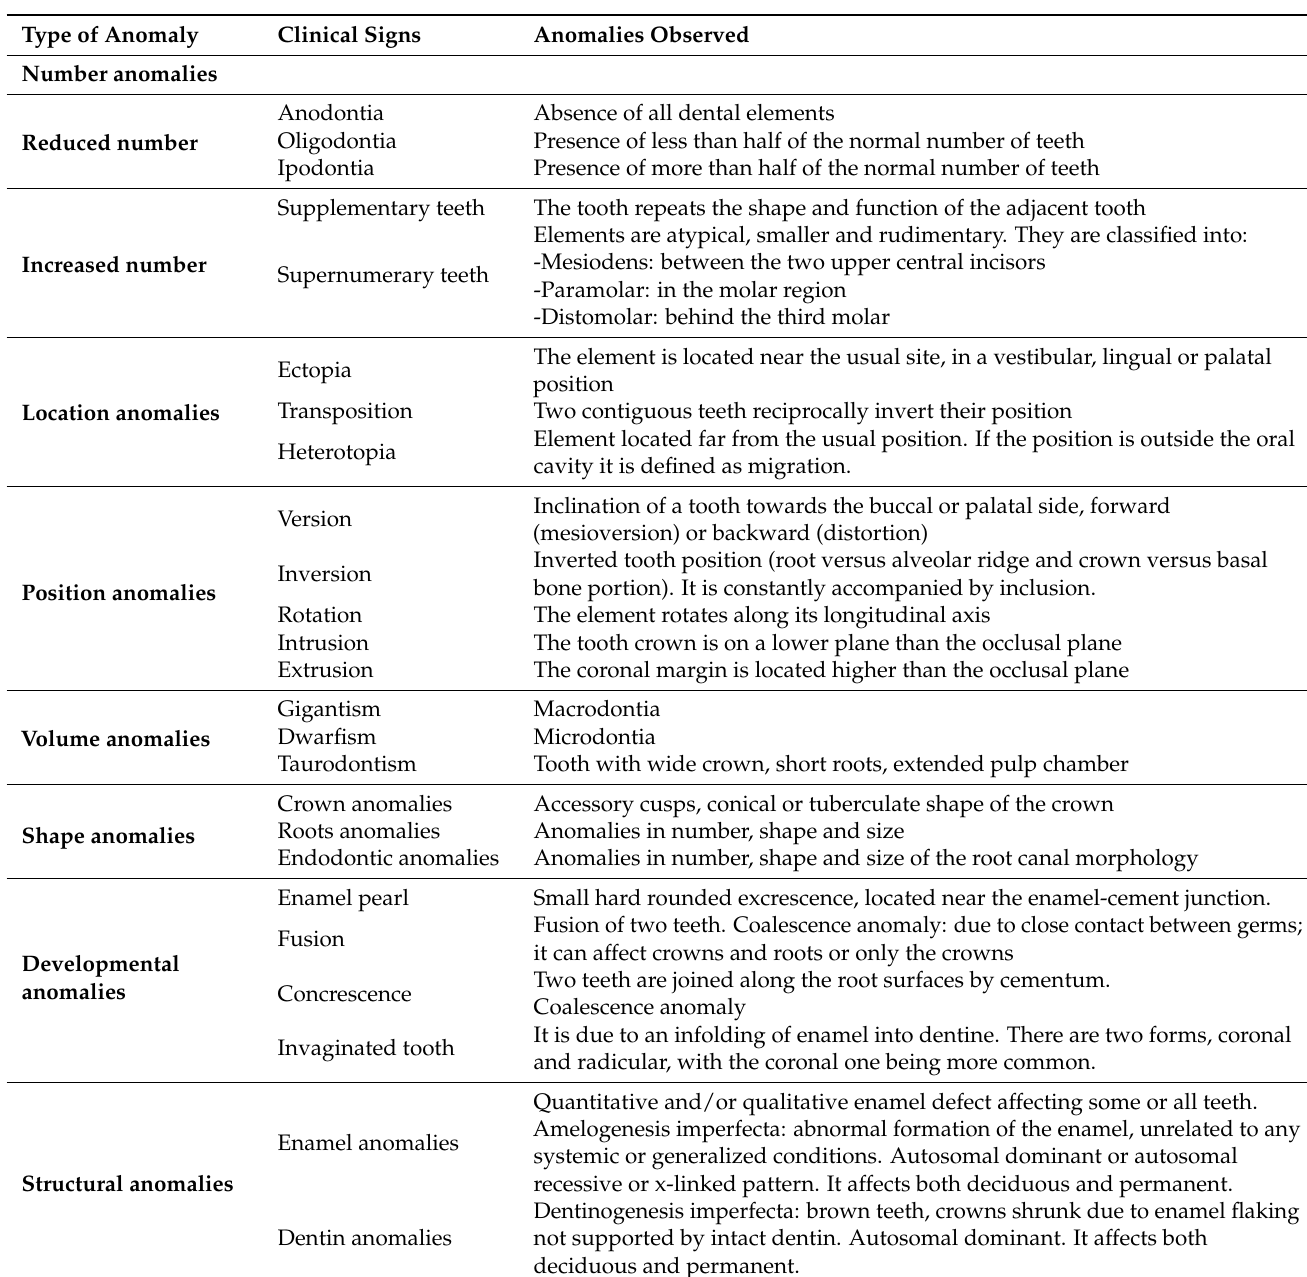
Table 1. Simplified table of dental anomalies and oral warning